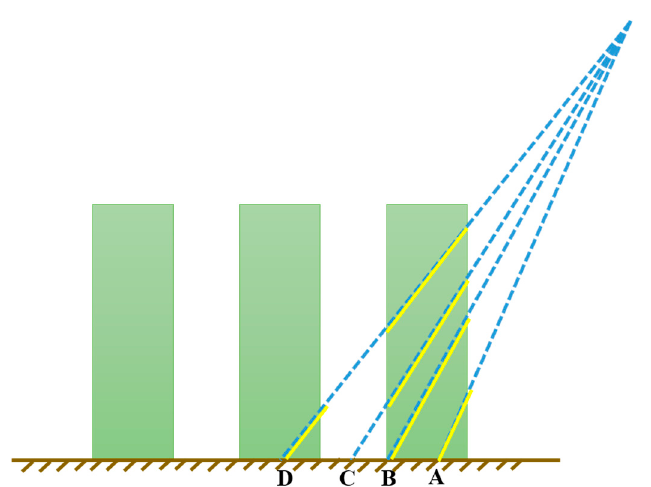
Figure 1. Illustration of effective path length variation with view zenith angles.